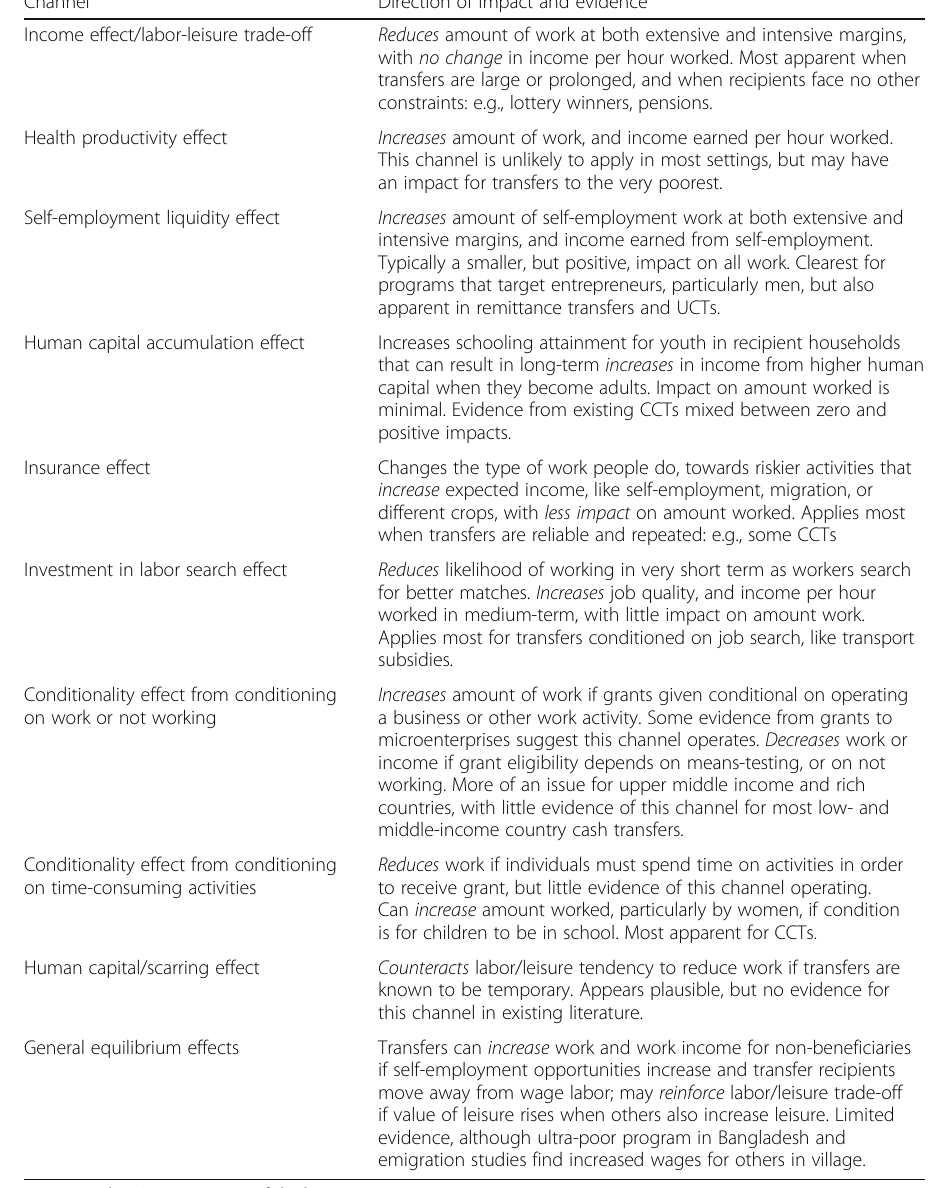
Table 2 Summary of different channels through which cash transfers affect labor outcomes Channel Direction of impact and